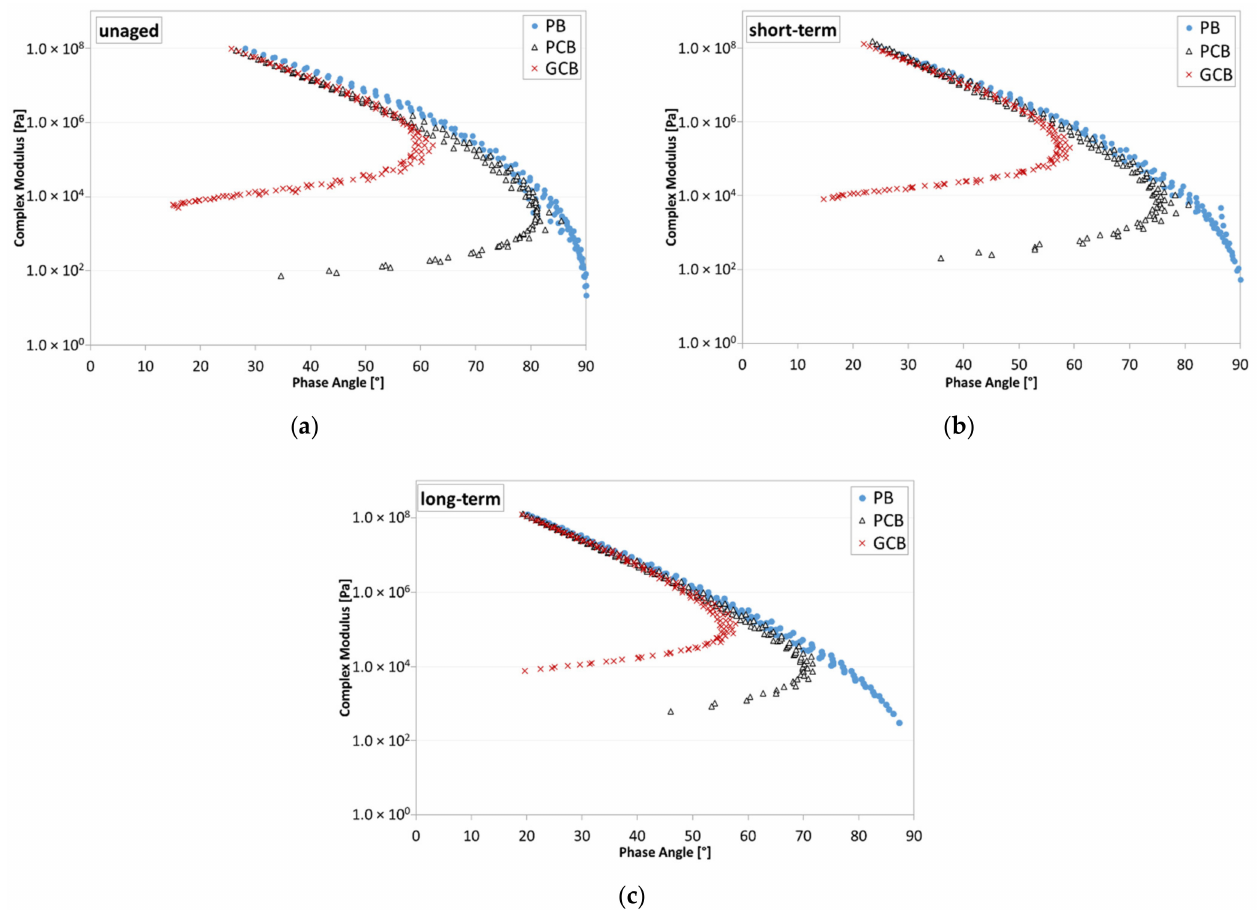
Figure 11. Black space of bituminous blends: ( a ) unaged condition; ( b ) short-term aged condition; ( c ) long-term aged condition.